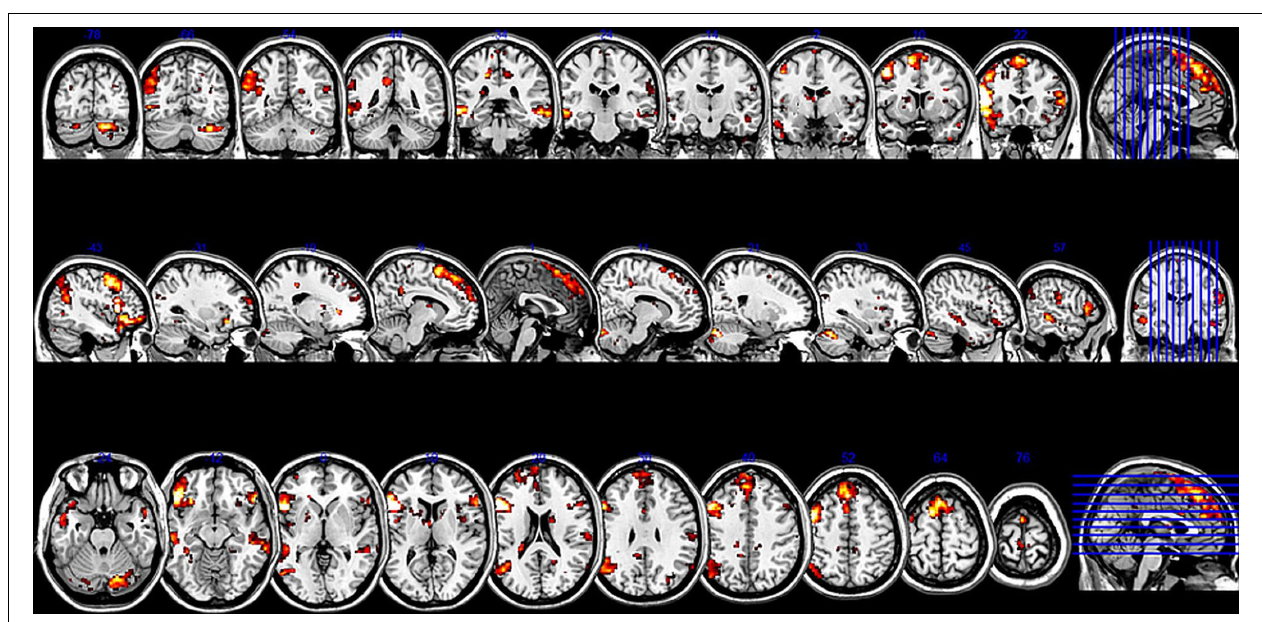
FIGURE 2 | Sliced version of the cluster map for the two seeds in Broca’s area. The figure shows coronal, sagittal, and axial slices of the cluster map of the resting state analysis with seeds in the pars